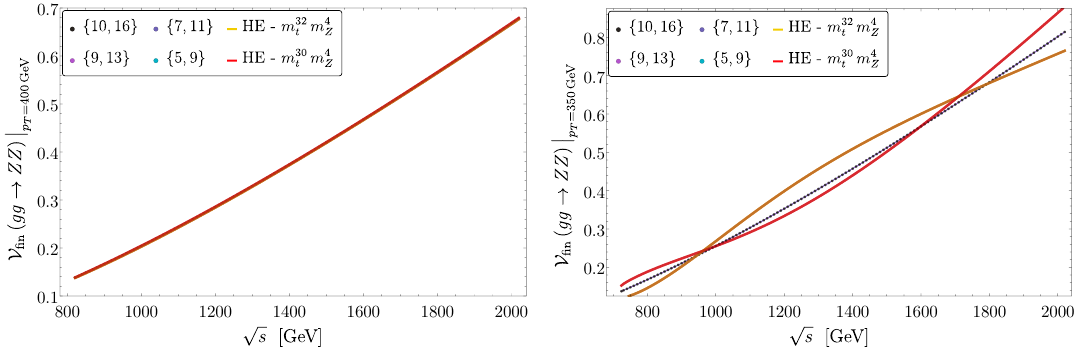
Figure 7 . as a function of p s for p T values of 400 and 350 GeV. The curves denoted \HE" V (cid:12)n show the high-energy expansion to orders m 30